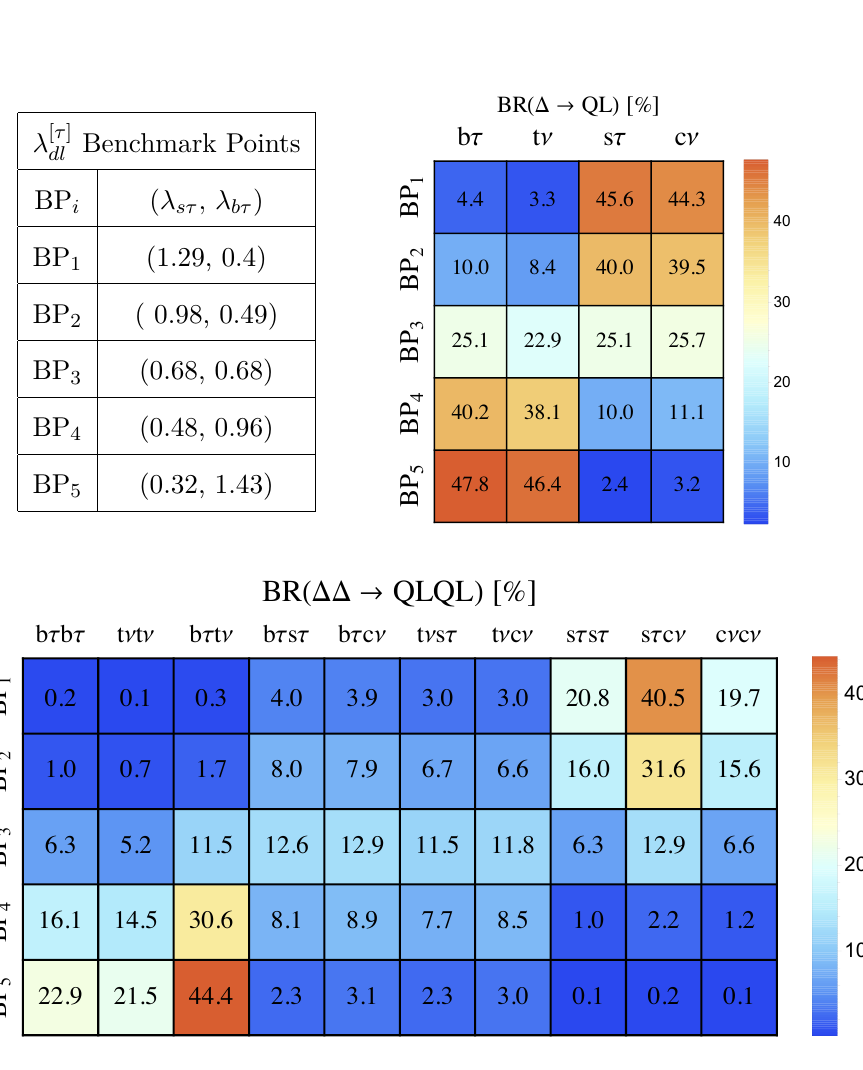
scan of section 3. dl